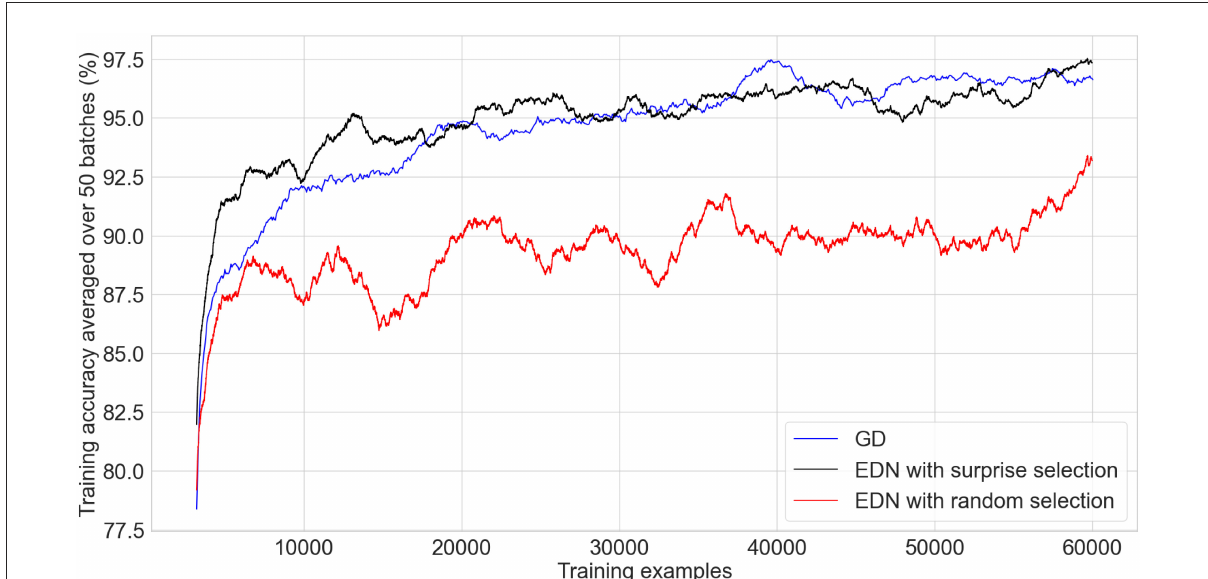
FIGURE7 A comparison of an ANN trained in tensorflow using ADAM optimization (black) against EDN with surprise driven input selection (blue) and random input selection (red) applied to the MNIST classification task. A batch size of 64 is used to train the ANN and the moving average of the last 50 batches is used to calculate the running training accuracy. EDN training accuracy is the moving average of the last 3,200 (50*64) training examples as it does not perform batch updates. Training accuracy is used as, since these are the results of the first epoch, non of the data has been seen before and therefore it is equivalent to testing